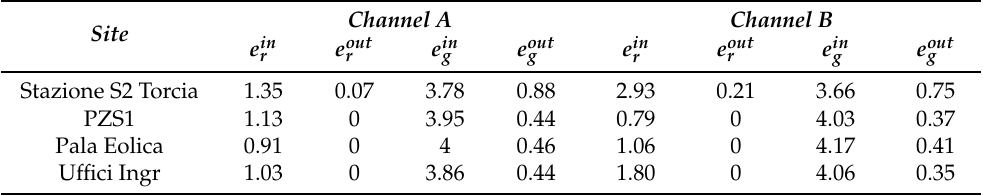
Table 3. Mean errors computed inside and outside the rainfall’s temporal windows achieved with the SRS sensors available at the Monte Scarpino landfill on 14 August